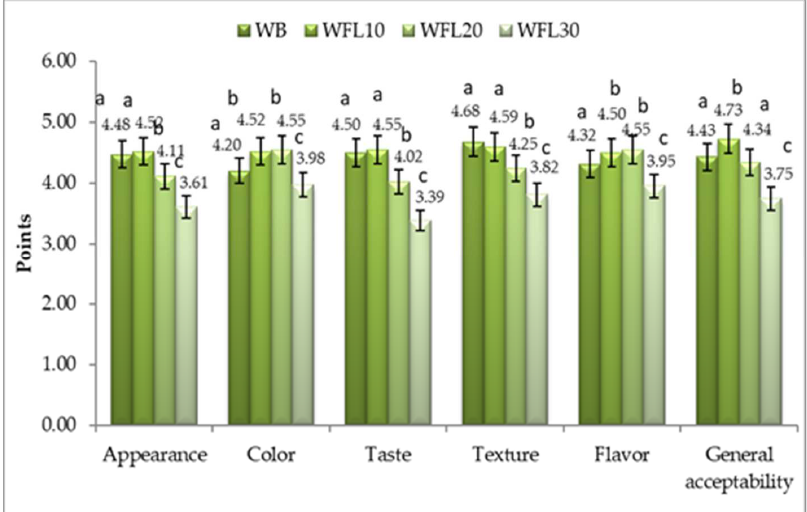
Figure 3. Global values of the sensory evaluation (consumer acceptance) of bread with lupin: WB (control bread); WFL10 (10% lupin flour and 90% wheat flour); WFL20 (20% lupin flour and 80% wheat flour); and WFL30 (30% lupin flour and 70% wheat flour) by using a 5-point hedonic scale ( n = 44). a,b,c— t -test has been used to compare the differences recorded between the samples for each characteristic assessed; data within the same column sharing different superscripts are significantly different ( p <